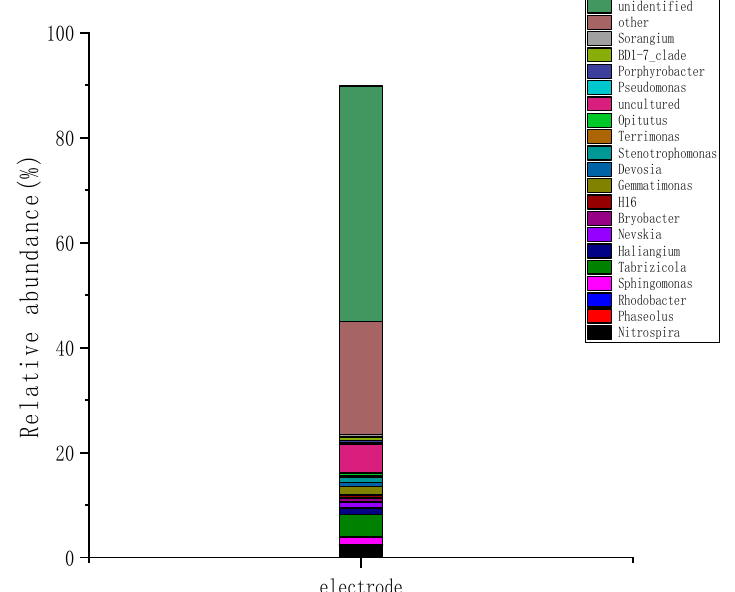
Figure 8. Changes in microbial genera at the wetland electrode.